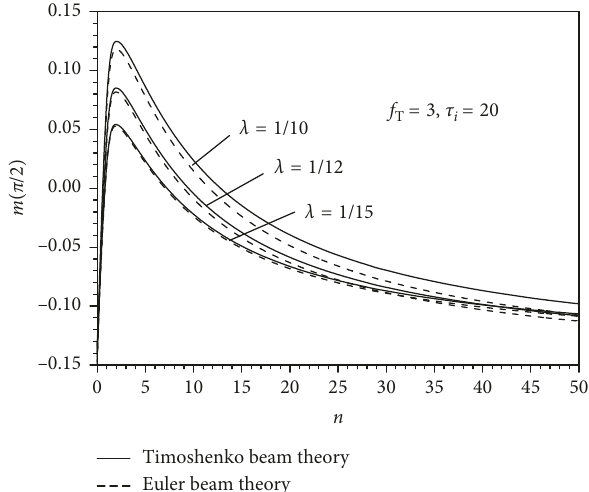
Figure 4: Dimensionless bending moment m elliptic FGM curved beam versus the power index n for different values of λ ( δ